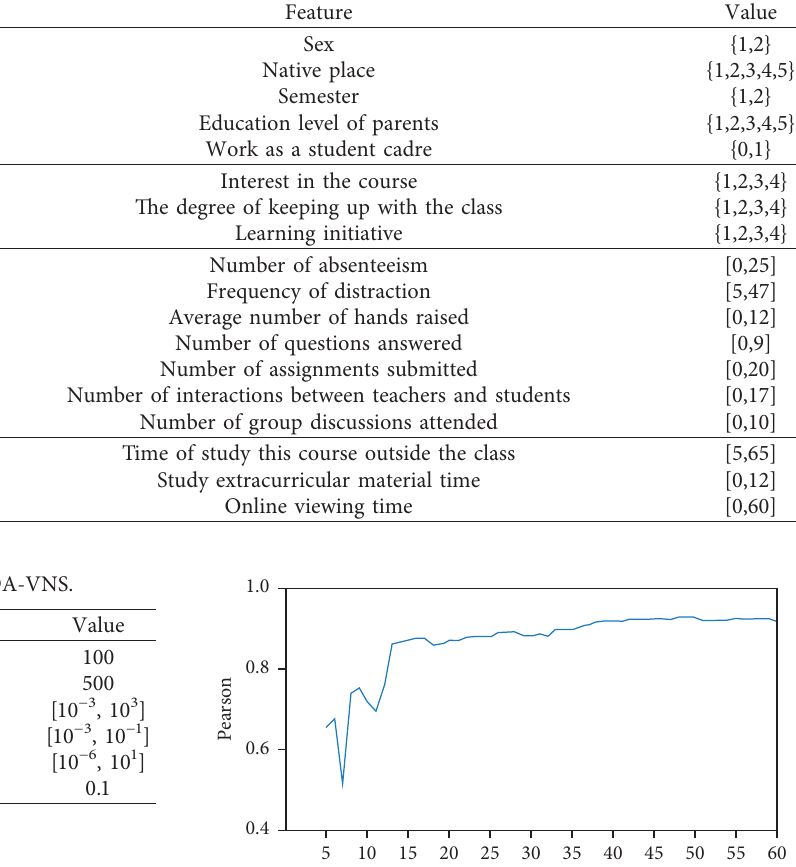
Figure 5: The accumulative Pearson’s correlation coefficient be- tween the actual value and the predicted value.